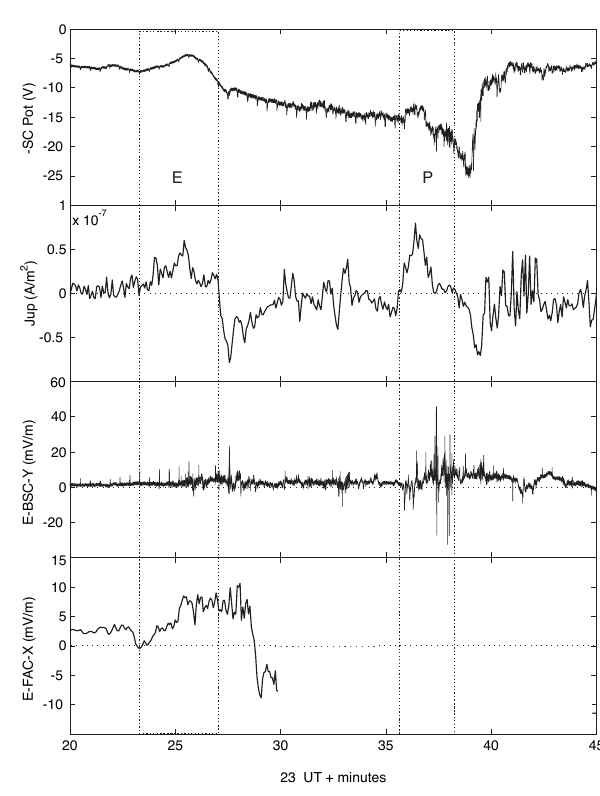
Fig. 5. Cluster 1 EFW anf FGM measurements. Panels from top to bottom: Negative of the s/c potential, FAC density (positive away from the ionosphere), BSC-Y component of the high-resolution electric field (every 10th point shown) and FAC-X component of the DC electric field. The equatorward (poleward) arc are denoted by E (P).